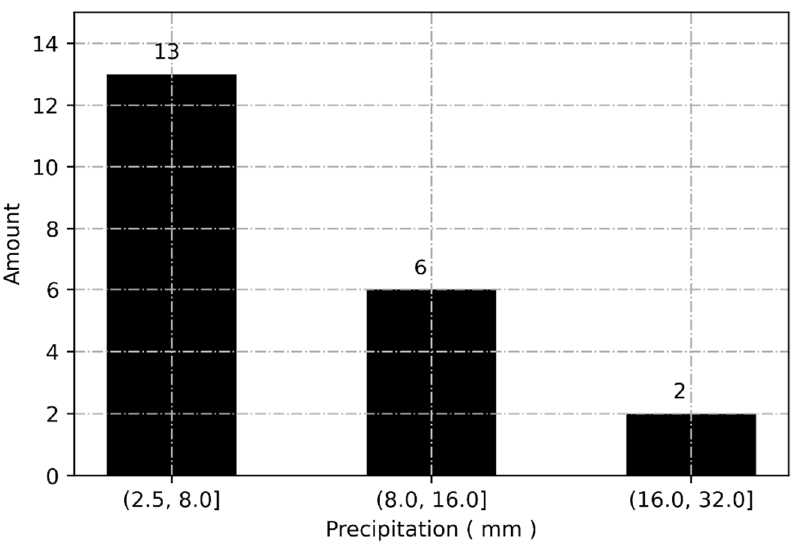
Figure 11. Quantity distribution of false alarm precipitation reports in each precipitation interval.